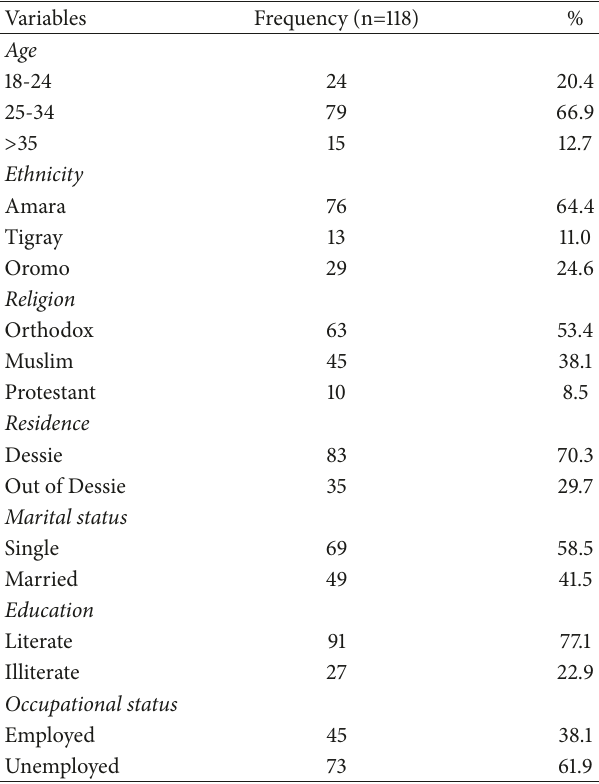
Table 2: Distribution of sociodemographic characteristics among abortioncareserviceclientsinMariestopesinternationalandDessie health center, Dessie, North eastern Ethiopia, 2017